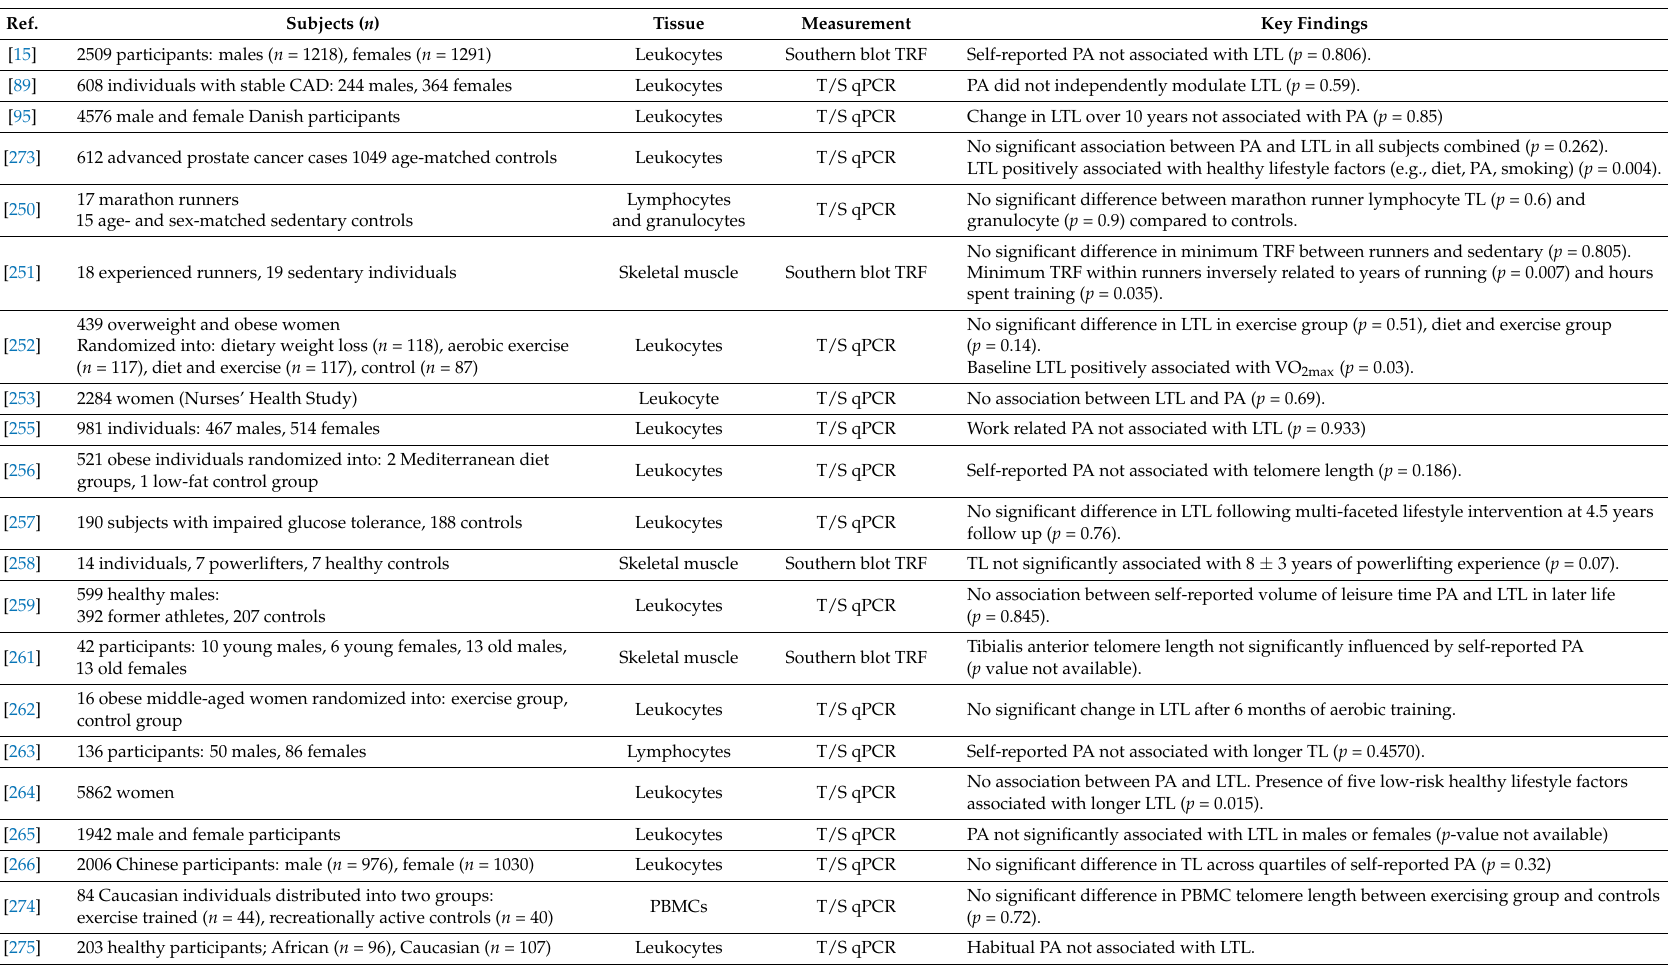
Table 2. A summary of studies showing no association between physical activity and telomere